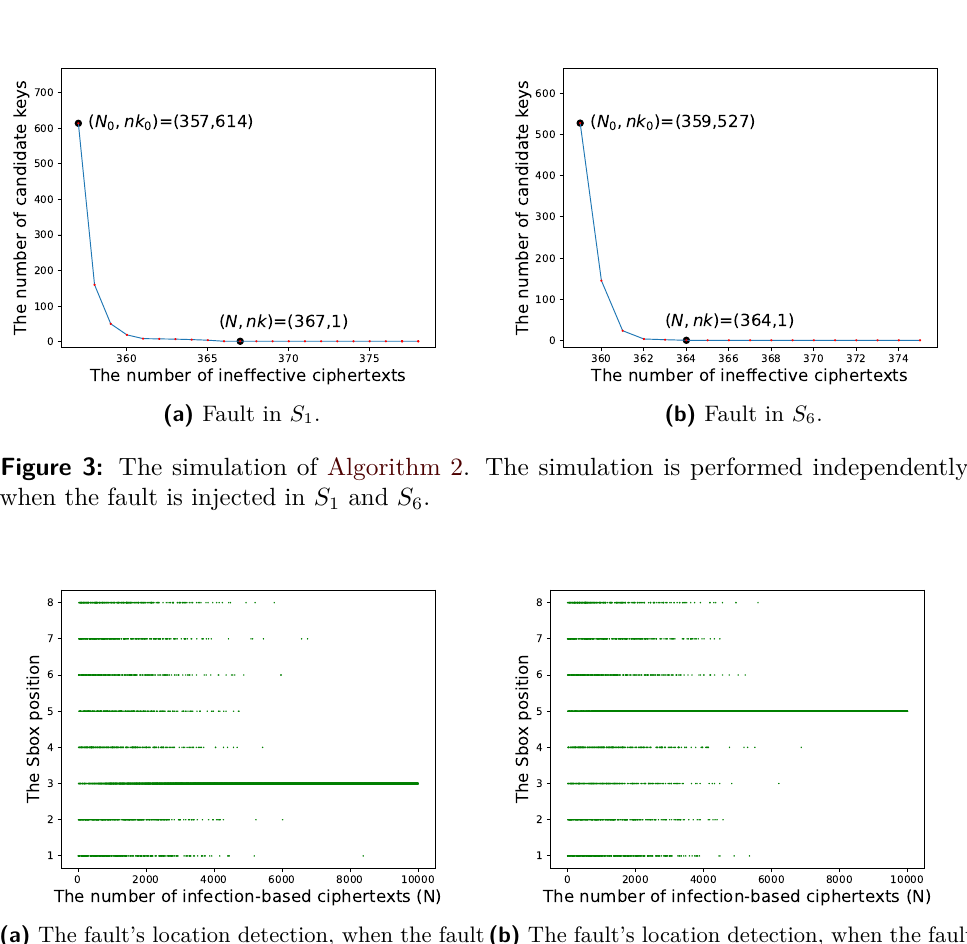
Figure 4: The simulation of the first part of Algorithm 4 for determining the fault location in DES in infection-based